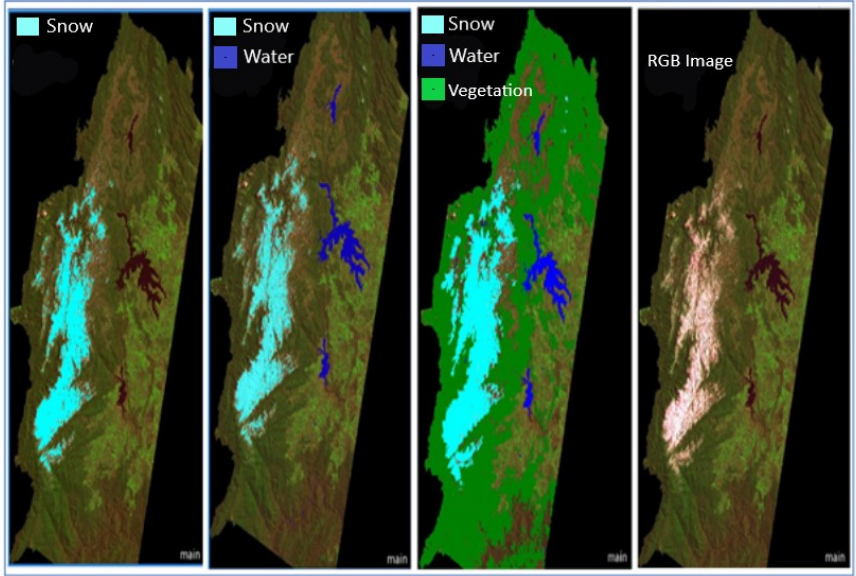
Figure 5. The sequence of generation of the indices NDSI (snow), SWI (water), and NDVI (vegetation) in comparison to the RGB image to the right. Table 2. MSD frequency during the cold months and linear correlation coefficients among the three SD observations sites.